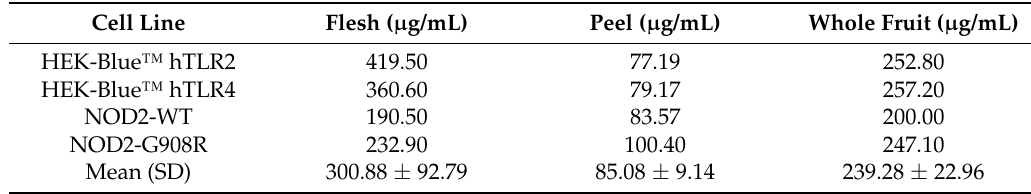
Table 1. IC50 Cytotoxicity of APOLLO extracts on the HEK-Blue and nucleotide-binding oligomerization domain-containing protein 2 (NOD2) cell lines using the sulforhodamine B (SRB)